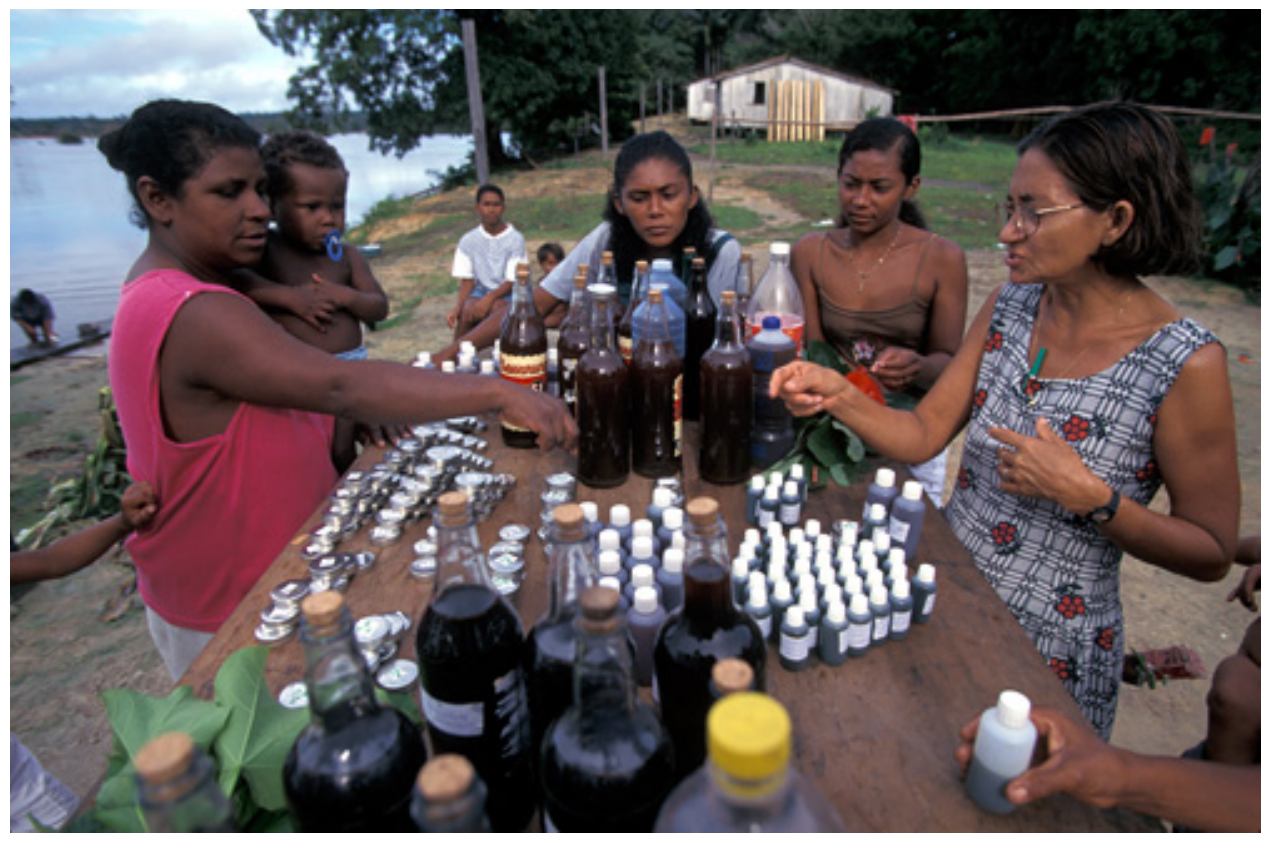
Fig. 1. Glória, at the far right, conducts medicinal plant workshops to illustrate how some common illnesses can be treated effectively using local plants. Photo: Joel